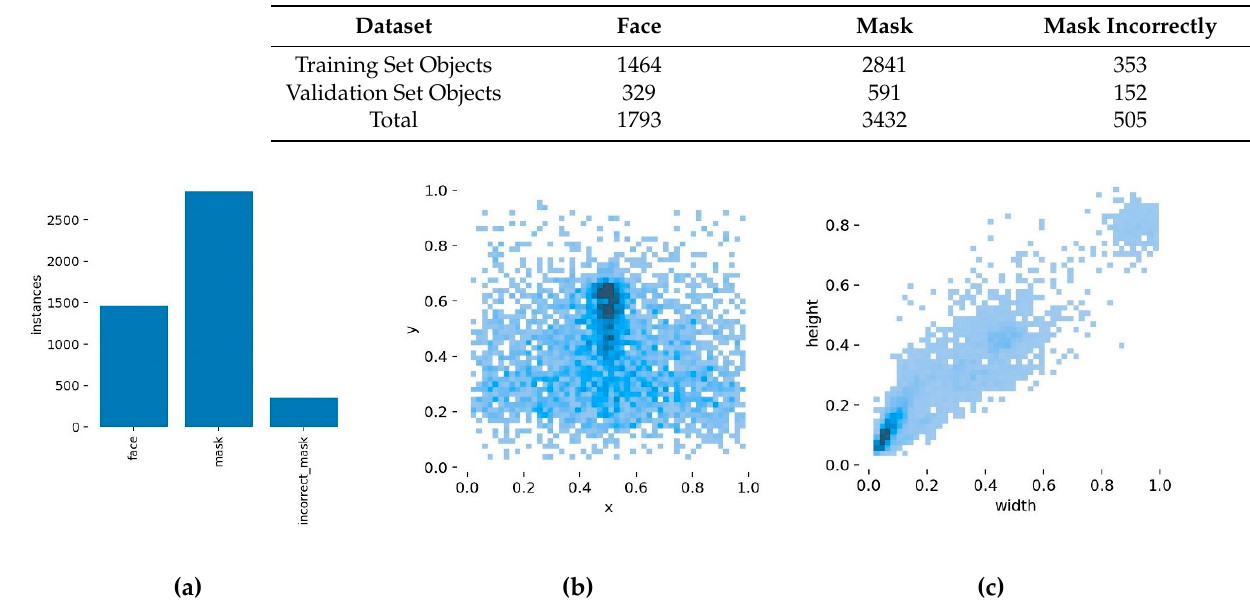
Table 2. Distribution of different types of samples in the data set.